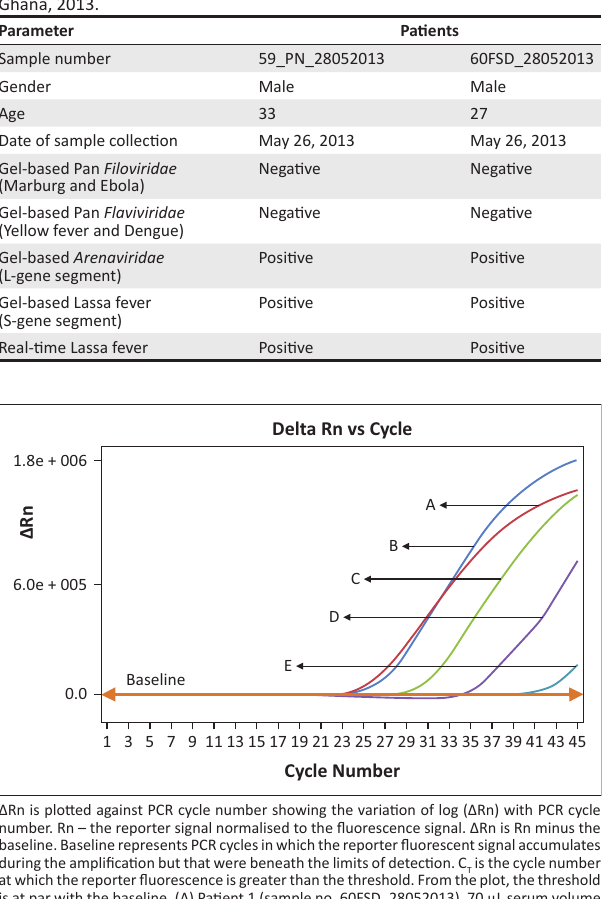
FIGURE 2: Ethidium bromide-stained 2 % agarose gel image of the PCR products generated from the two patients samples run in